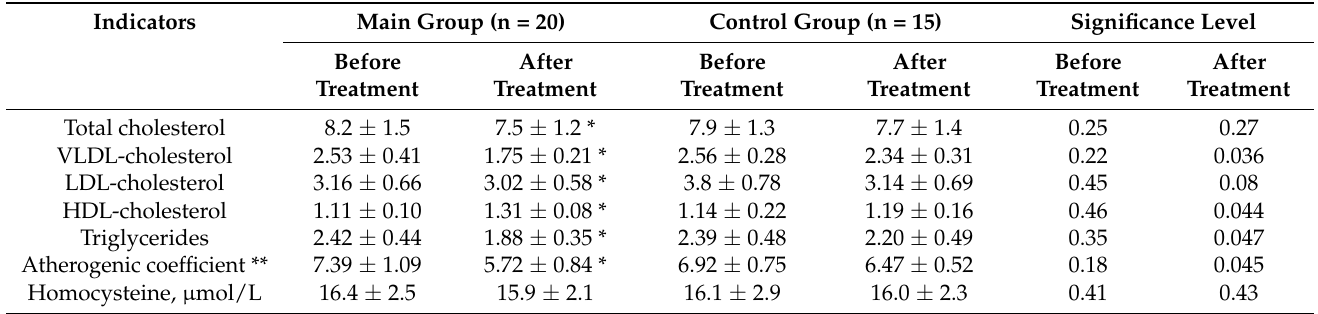
Table 6. Blood lipid spectrum indicators of people with chronic venous insufficiency (CVI) during treatment.